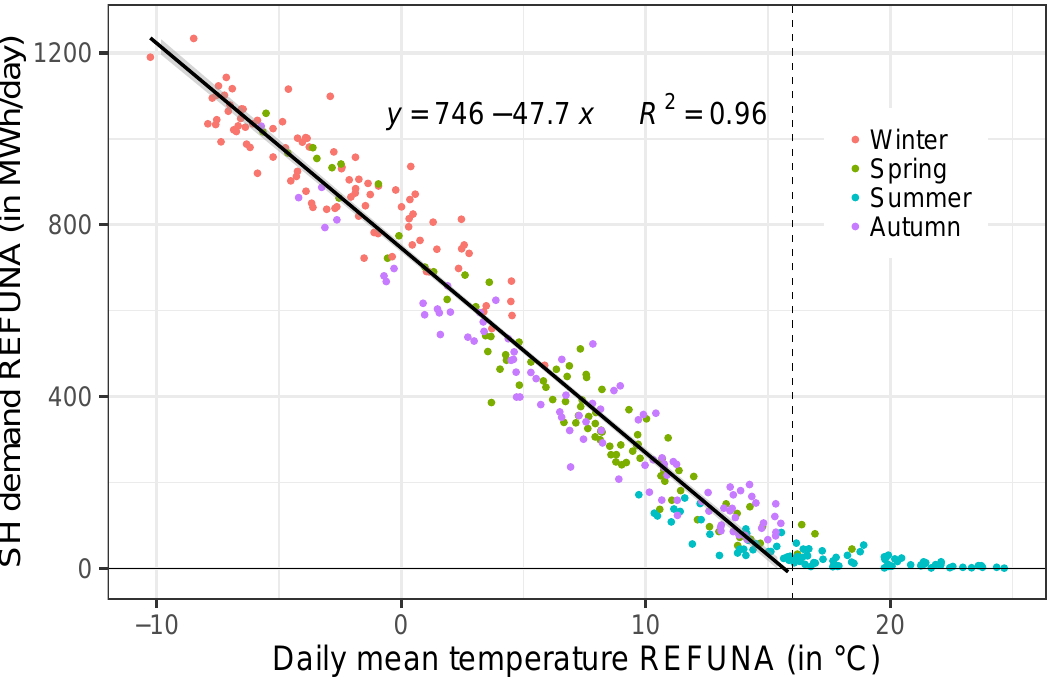
Figure 3. Linear regression of REFUNA’s daily space heating (SH) demand versus Beznau’s daily mean temperature, for daily mean temperatures below 16 °C (heating threshold temperature).